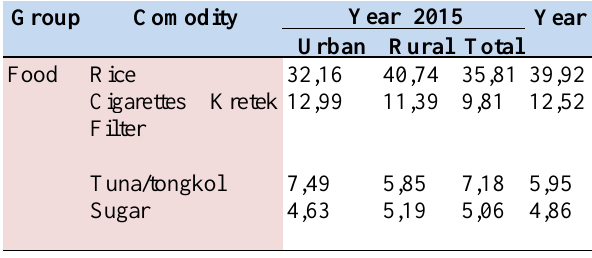
Commodity contributor to poverty timeframe of 2015 to